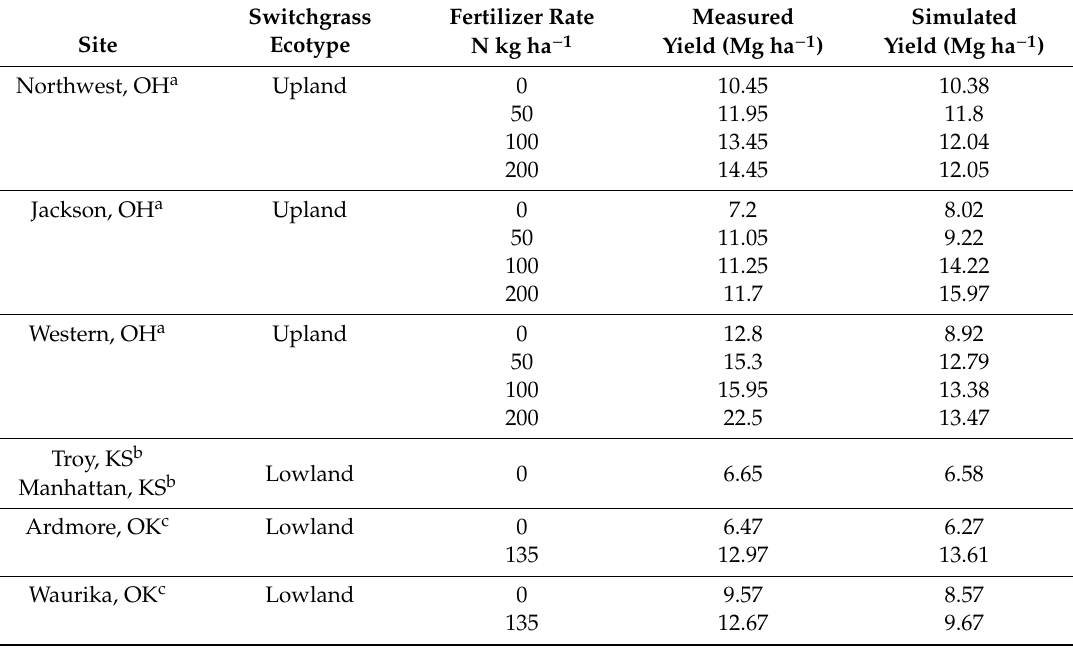
Table 2. Measured and simulated yields at di ff erent nitrogen (N) fertilizer rates for upland and lowland cultivars at Ohio, Kansas, and Oklahoma, USA. Switchgrass